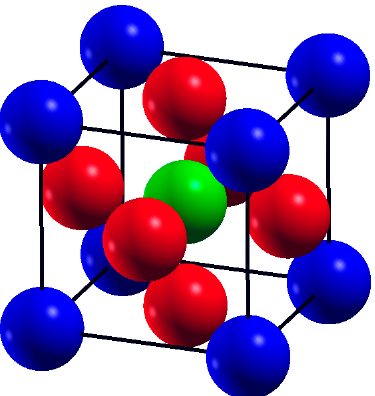
Table 1. Calculated lattice parameter ( a ), bulk modulus ( B ), first pressure derivative ( B ’) of SrTMO 3 (TM-Rh, Zr).